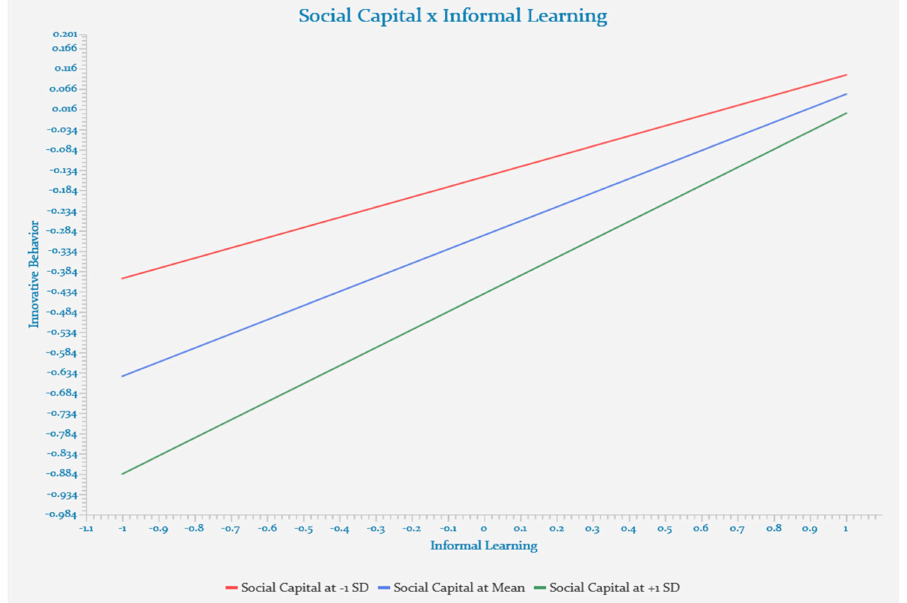
Figure 2. Moderated mediating effect of social